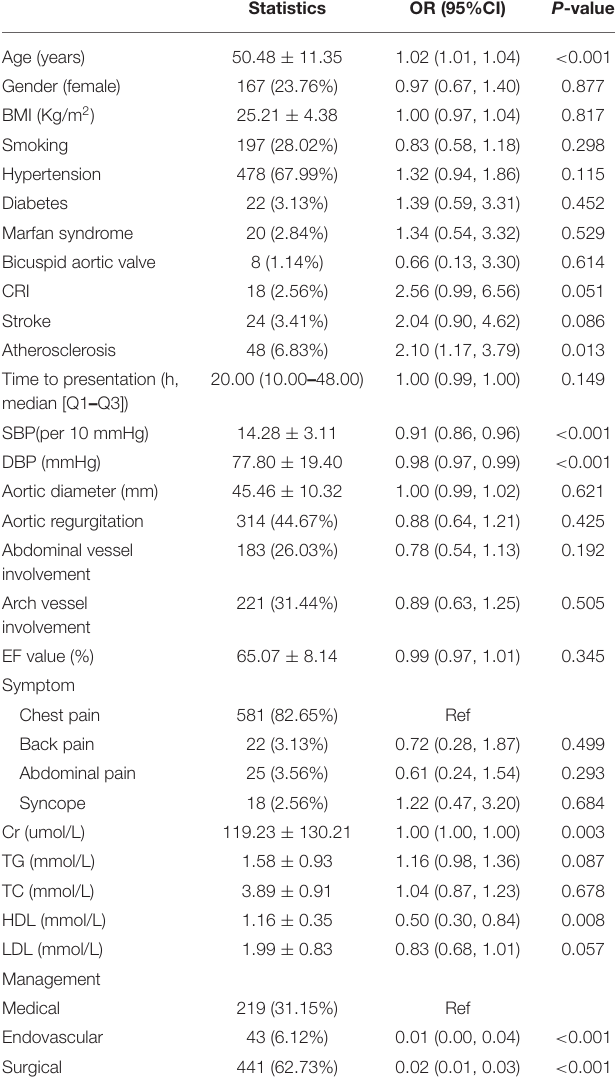
TABLE 2 | Univariate analysis for in-hospital mortality.